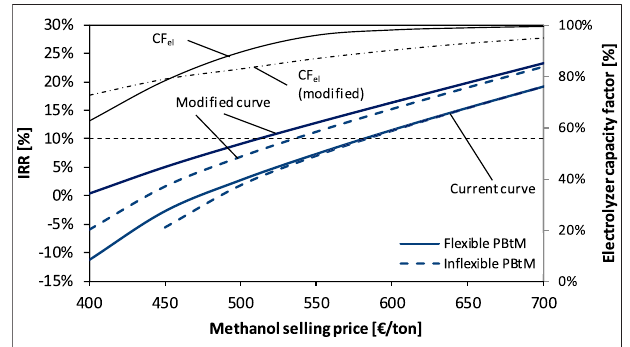
FIGURE 10 | IRR of the DG-based plant as a function of the methanol selling price for an electrolyzer investment cost of 400 € /kW. Curves are derived from the two electricity price curves shown in Figure 9 .